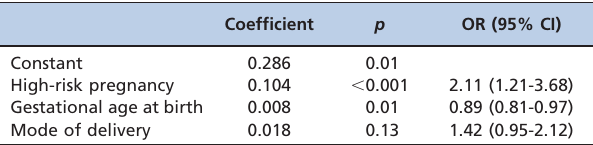
Table 2 - Significant predictors of maternal postpartum complications in twin deliveries. High-risk pregnancy (0 = no, 1 = yes), gestational age at birth in weeks, mode of delivery (1= vaginal, 2 = elective cesarean section, 3 = emergency cesarean section). The significance level was set at 0.20. OR: odds ratio, CI: confidence interval.